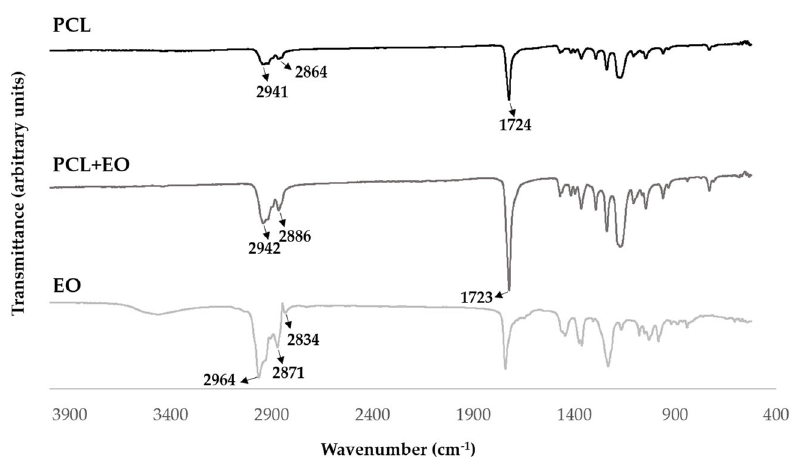
Figure 4. FTIR-ATR analysis of the PCL, PCL + EO, and EO. Figure 4. FTIR ‐ ATR analysis of the PCL, PCL + EO, and EO.